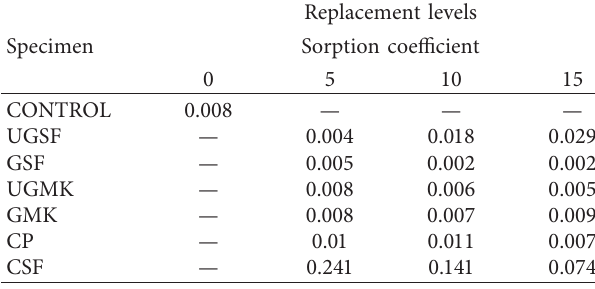
Figure 15: Water absorption values of MK.